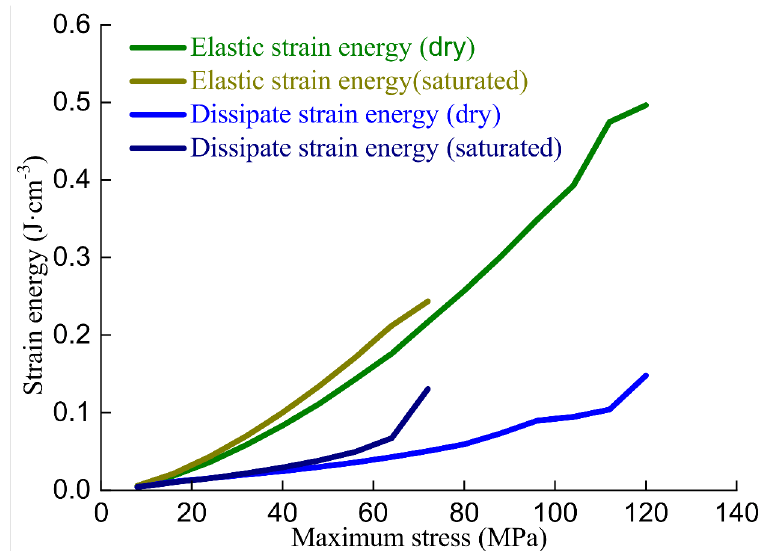
Figure 8. The curve of strain energy with maximum stress.